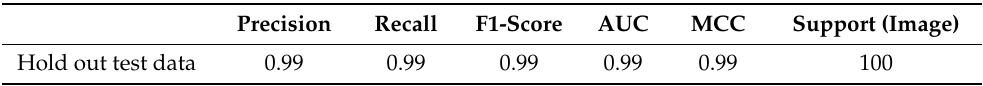
Table 6. Model performance using hold out test